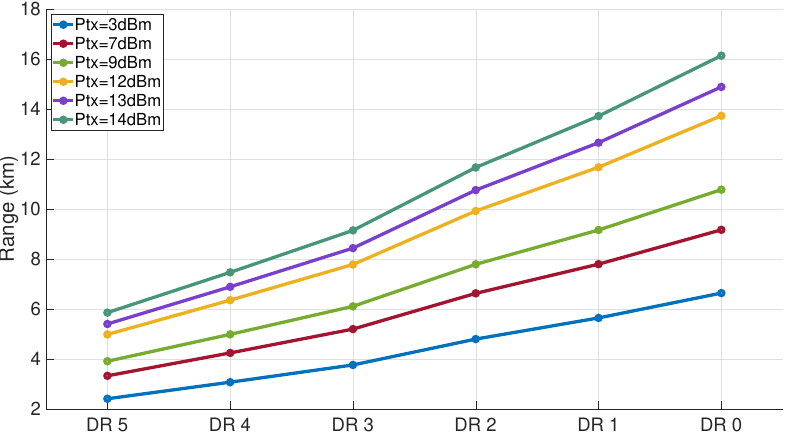
Figure 16. Maximum LoRa node range vs. DR and transmit